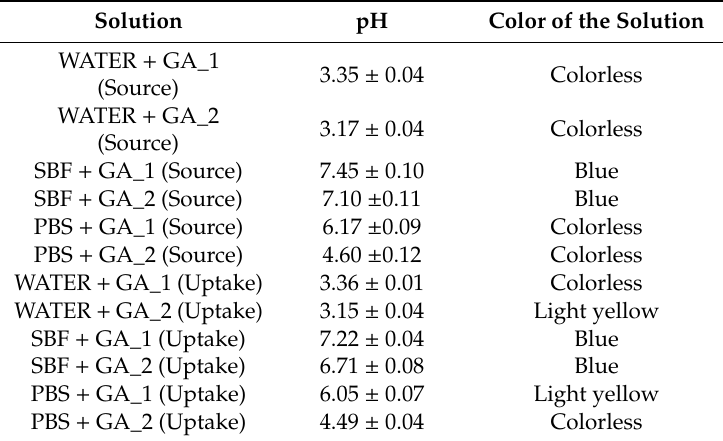
Table 2. pH values of the source and uptake